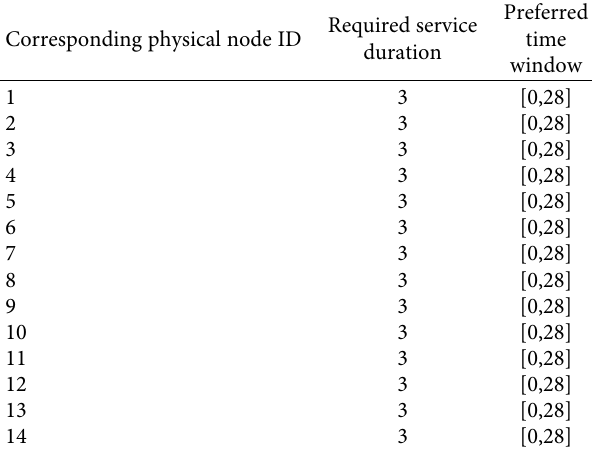
Table 6: Basic information of delivery requests in the illustrative